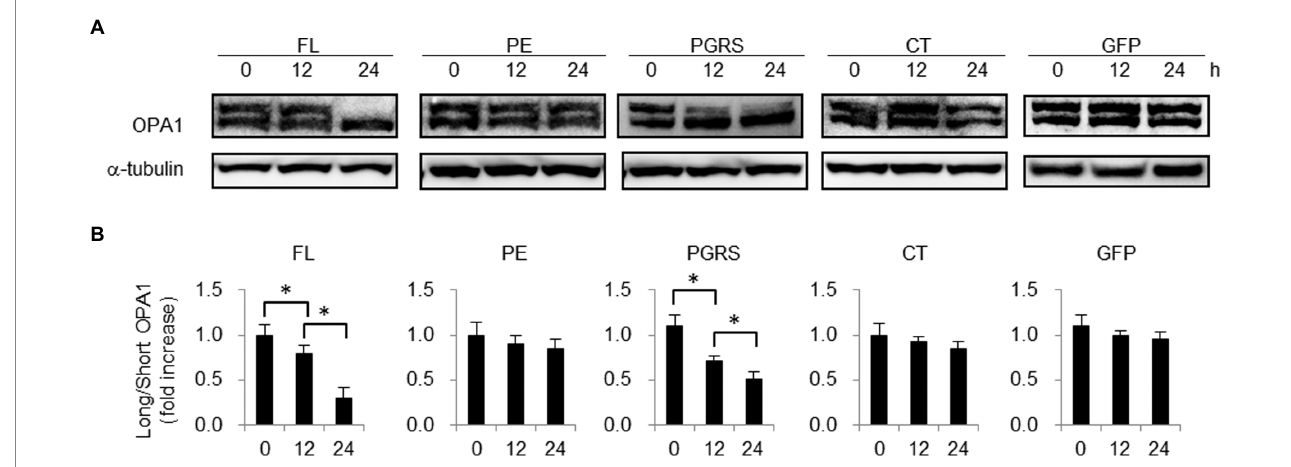
FIGURE 5 PHB2 function in mitochondria is impaired in response to PGRS domain. (A) Long and short isoforms of OPA1 in RAW264.7 cells treated with 10 μ g/ml FL, PE, PGRS, CT domain or control boiled GFP at the indicated time points. Long and short isoforms of OPA1 in whole cell lysates were detected by immunoblotting. α -tubulin served as loading control. (B) Quantification of long isoform of OPA1 protein in comparison with that of short form OPA1. Ratios of long-to short-isoforms of OPA1 protein measured by band densities are presented. Means ± SD are shown ( n = 3). * p < 0.05 using one-way ANOVA with Tukey’s multiple comparisons. (A,B) Data are representative of three independent